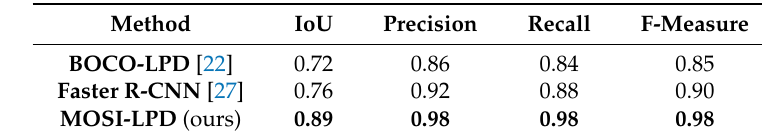
Table 1. Performance comparison between BOCO-LPD [22], Faster R-CNN [27] and our MOSI-LPD on overall